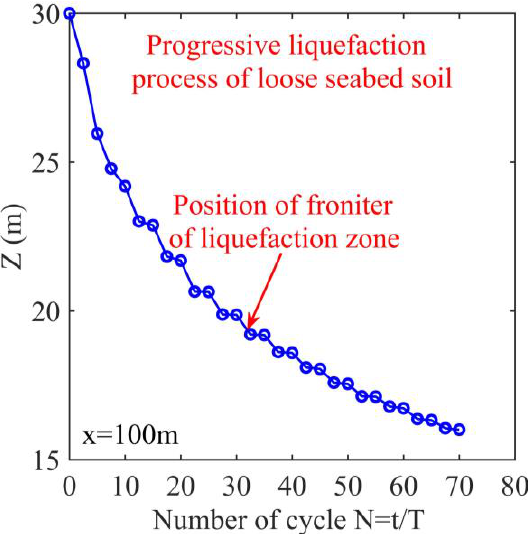
Figure 10. Position of the frontier of the residual liquefaction zone on x = 100 m, presenting that the liquefaction in loose seabed floor is a progressive process.